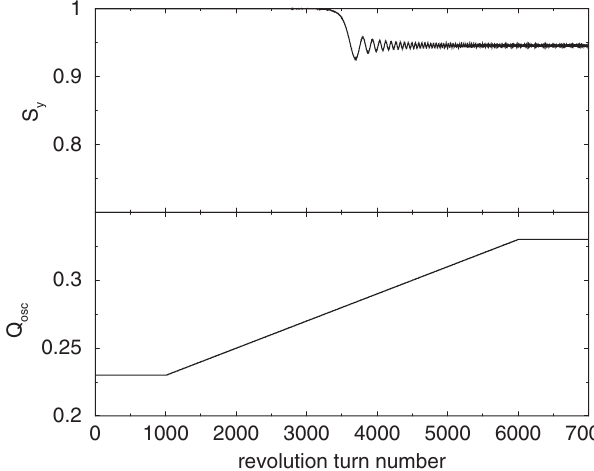
FIG. 1. Numerical simulation of spin vector of a particle cross- ing a rf dipole driven oscillation. The top curve shows the vertical component of the spin vector as a function of orbital turns. The bottom curve shows the rf dipole oscillating frequency versus the orbital turn number. A spin resonance is seen at G(cid:2)